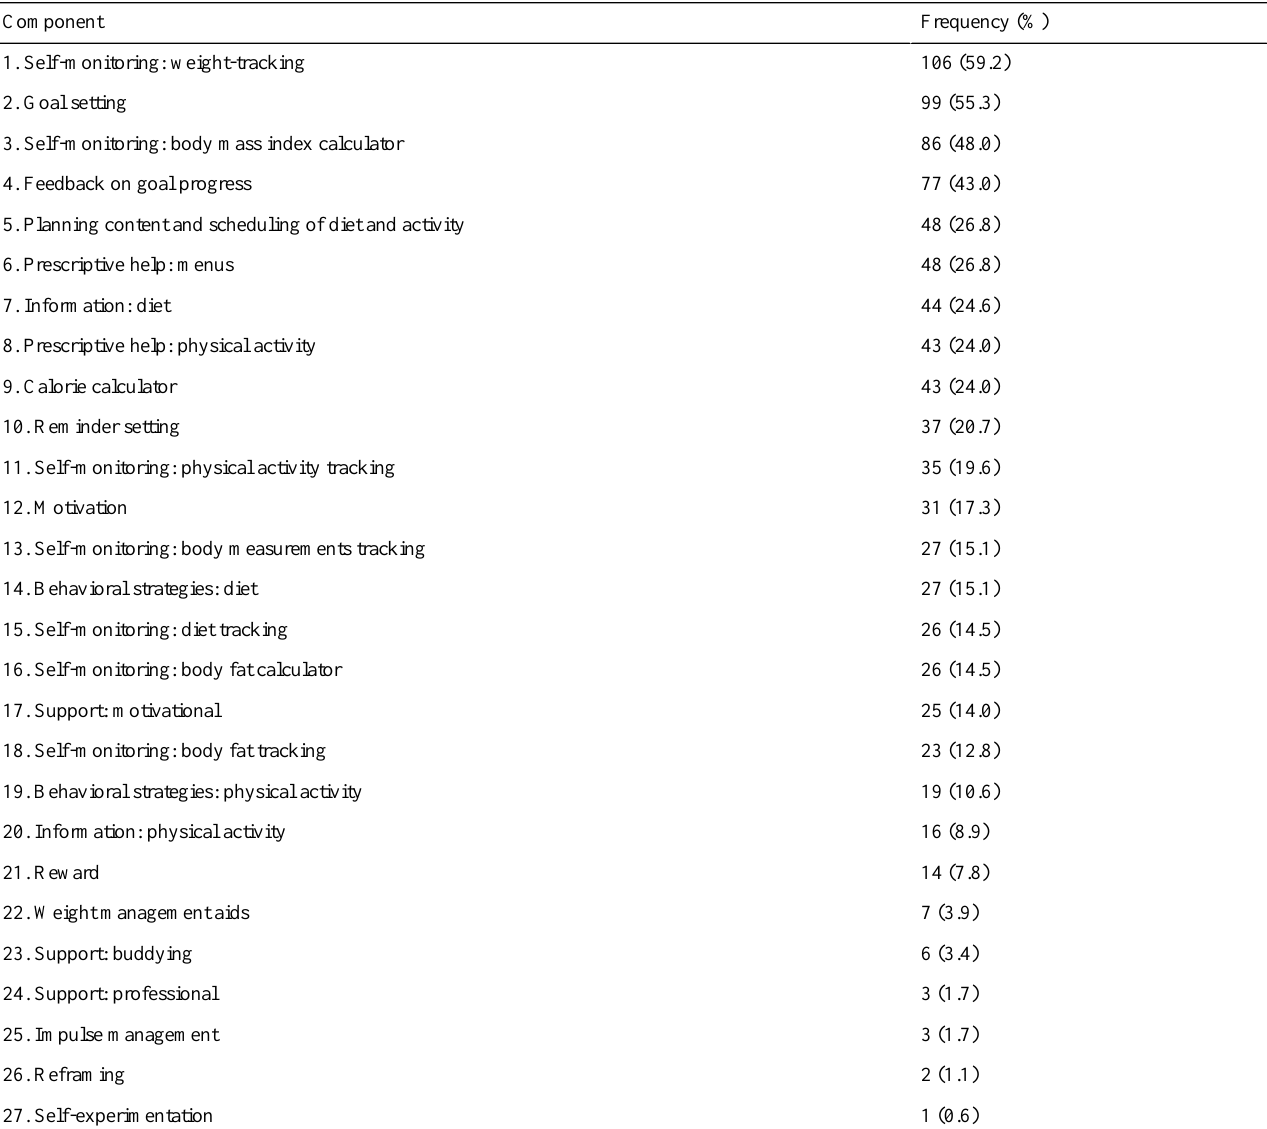
Table 2. Frequency with which the adapted Oxford Food and Activity Behaviors (OxFAB) components were coded in weight loss